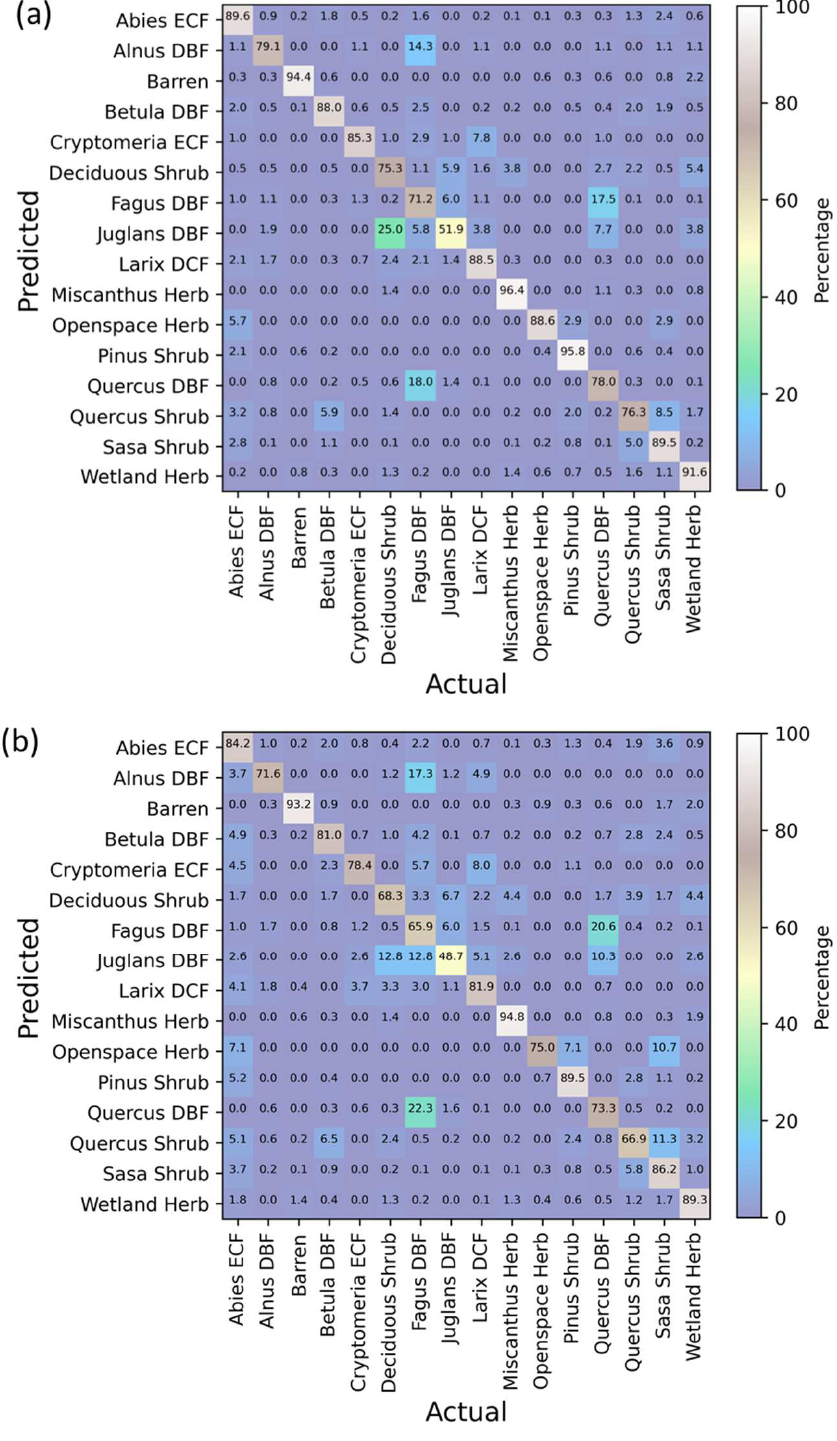
Figure 9. Performance of the ultra-resolution suite ( a ) over the very high-resolution suite ( b ) for the differentiation of land cover and vegetation types in the Hakkoda site using bi-seasonal images.